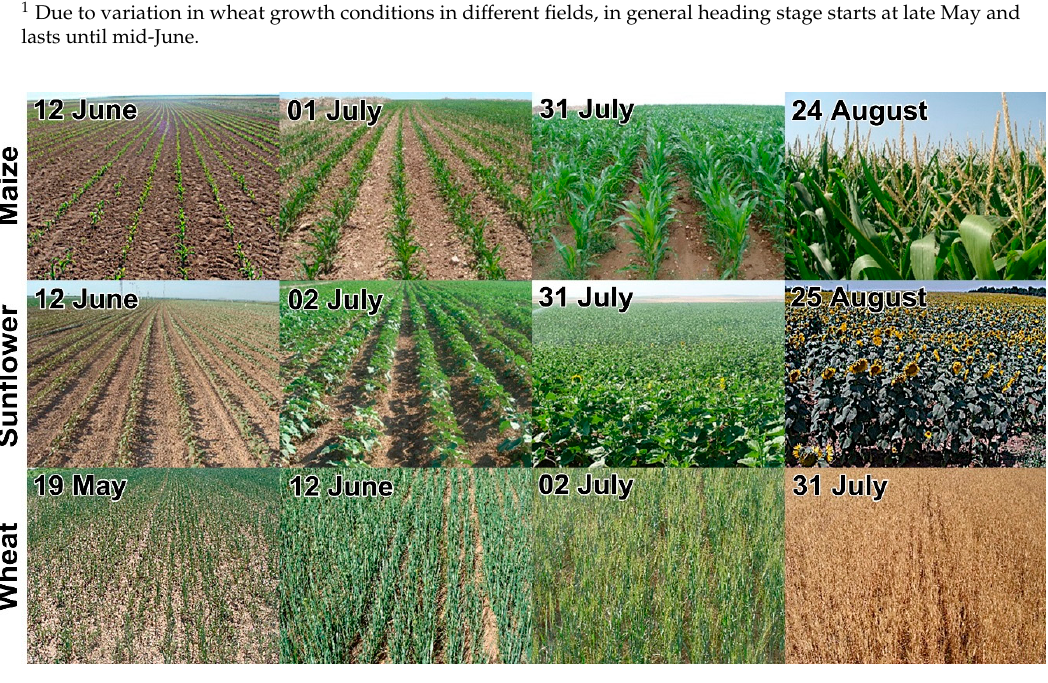
Figure 5. Different growth stages of crops in the study area.